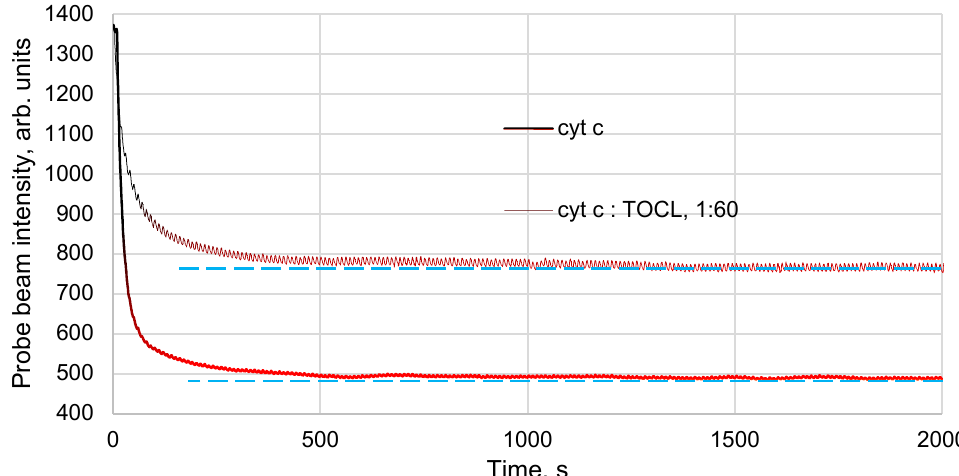
Figure 4. Thermal lens time-resolved signal (the blooming of the temperature field measured by a change in the intensity in the centre of the probe beam) of an aqueous solution of ferricytochrome c (4.0 µM) and the complex of ferricytochrome c of the same concentration with TOCL (Cyt c—TOCL; pH 7.4). Thermal lensing; 514.5 nm; 60 mW. Addition of TOCL results in a lower signal and a different development of the temperature fi eld.